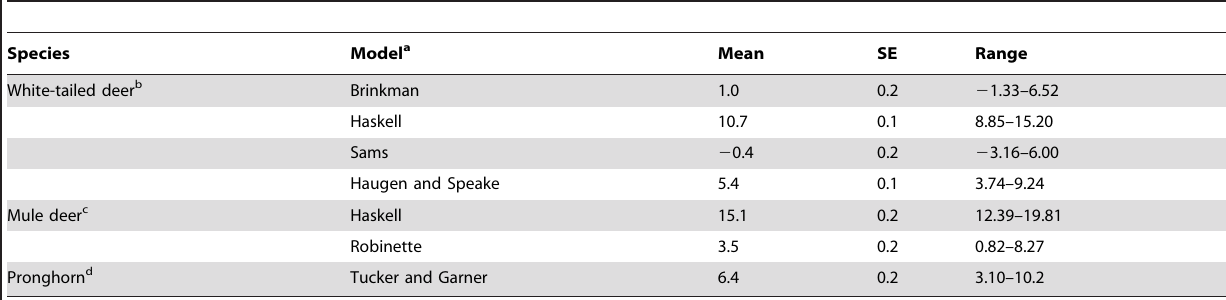
Table 2. Mean, standard error (SE), and range of age estimates (days) of newborn white-tailed deer ( n =71), mule deer ( n =61), and pronghorn ( n = 37) in Minnesota, South Dakota, and California, USA, 2001–2009.